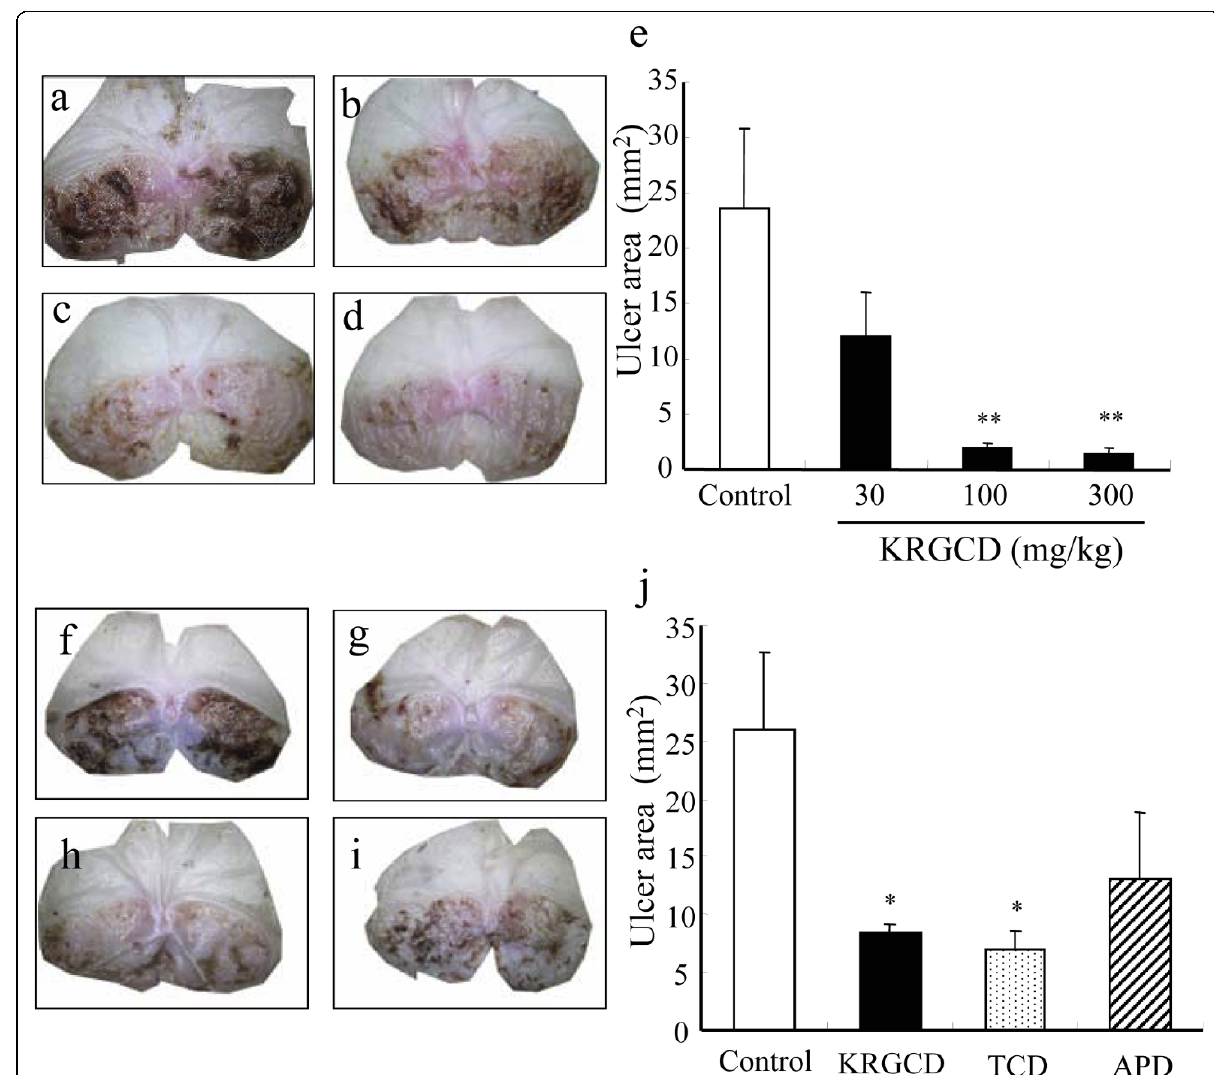
Figure 2 Protective effect of KRGCD on gastric mucosal lesions induced by indomethacin in mice . Stomachs from mice with vehicle (a) and pretreated with KRGCD at doses of 30 mg/kg (b), 100 mg/kg (c), and 300 mg/kg (d) at 1 hr before indomethacin administration. Quantitative analysis of KRGCD on the ulcer area (mm 2 ) induced by indomethacin (e). n = 6 for each group. Each value represents the mean ± SEM. ** p < 0.01 vs. control mice, Dunnett ’ s multiple-range test. Stomachs from mice with vehicle (f) and pretreated with KRGCD (100 mg/kg) (g), TCD (76 mg/kg) (h), and APD (96 mg/kg) (i) at 1 hr before indomethacin administration. Quantitative analysis of KRGCD, TCD, or APD on the ulcer area (mm 2 ) induced by indomethacin (j). n = 8 for each group. Each value represents the mean ± SEM. * p < 0.05 vs. control mice, Student ’ s t